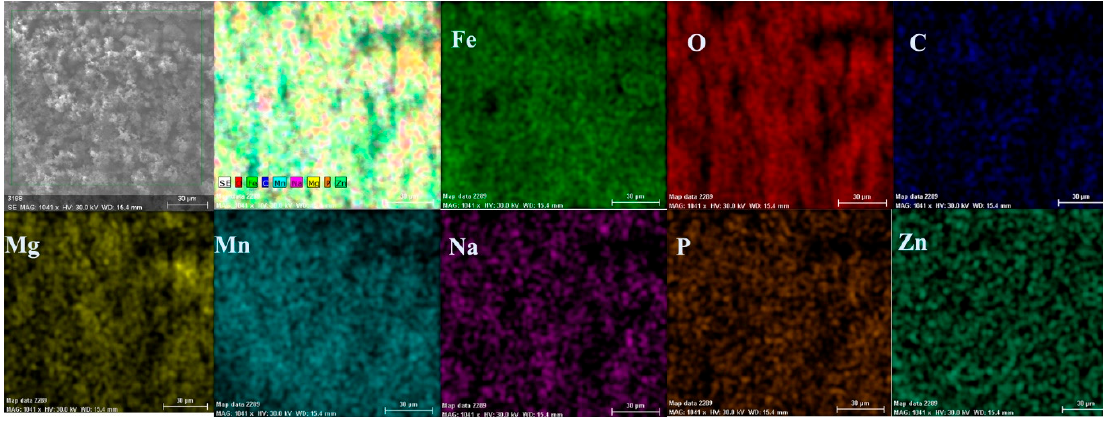
Figure 14. Elemental distribution in the crust on the PS surface, after 85 days of immersion in seawater.